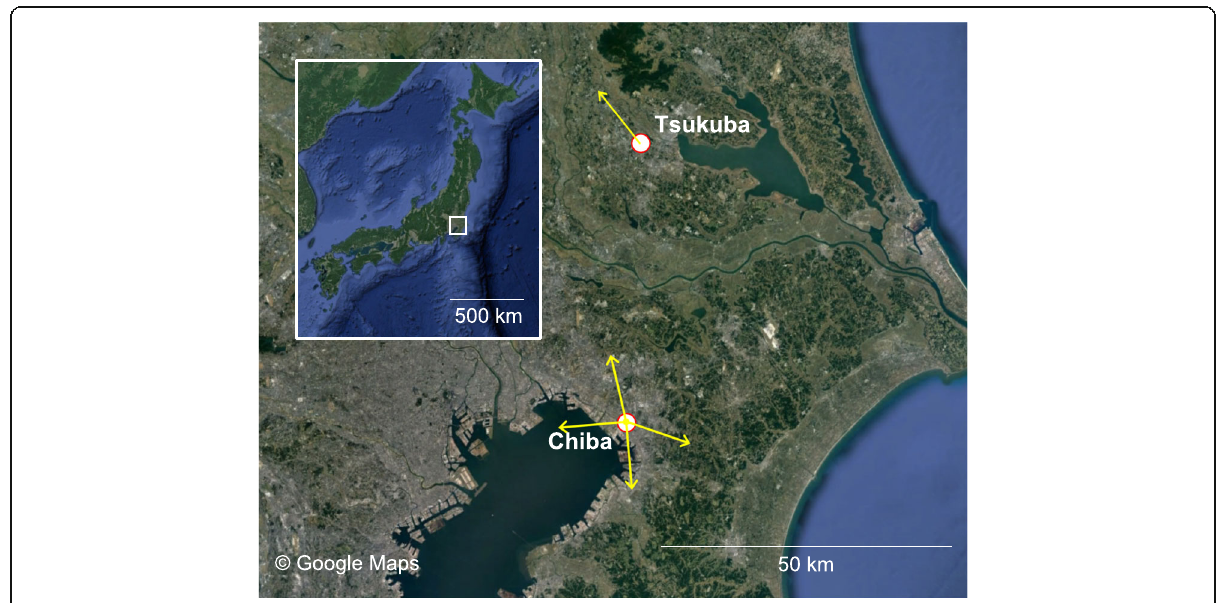
Fig. 1 Locations of the MAX-DOAS observation sites in this study (Chiba and Tsukuba, Japan). The lines with arrows represent the lines of sight for each MAX-DOAS instrument. The length of the lines represents a typical observation spatial scale of 10